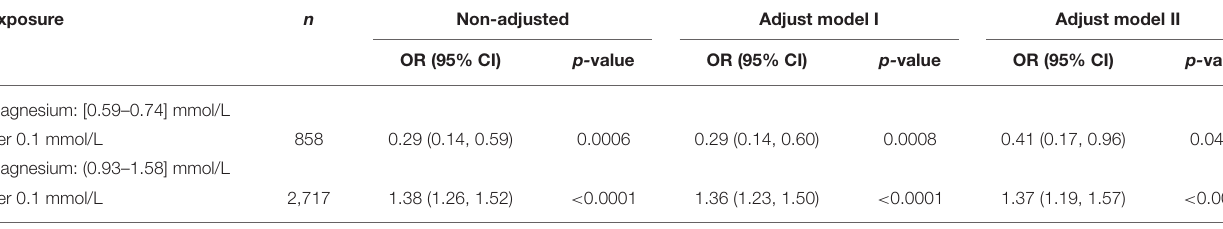
TABLE 4 | Individual effect of magnesium on 28-day in-hospital all-cause mortality using piece-wise linear regression. Exposure n Non-adjusted Adjust model I Adjust model II OR (95% CI) p- value OR (95% CI) p- value OR (95% CI) p-